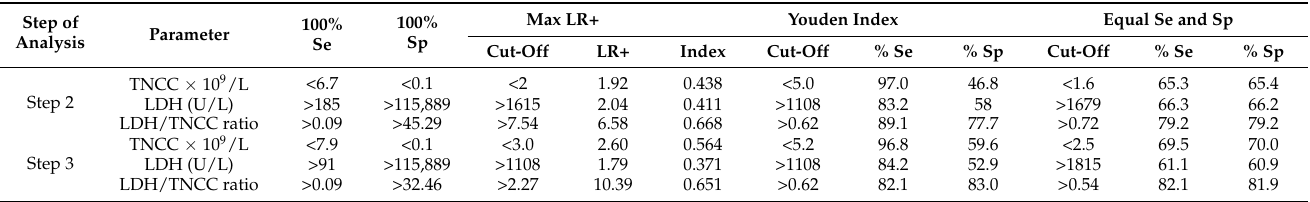
Table 7. Diagnostic performances of TNCC, LDH activity and LDH/TNCC